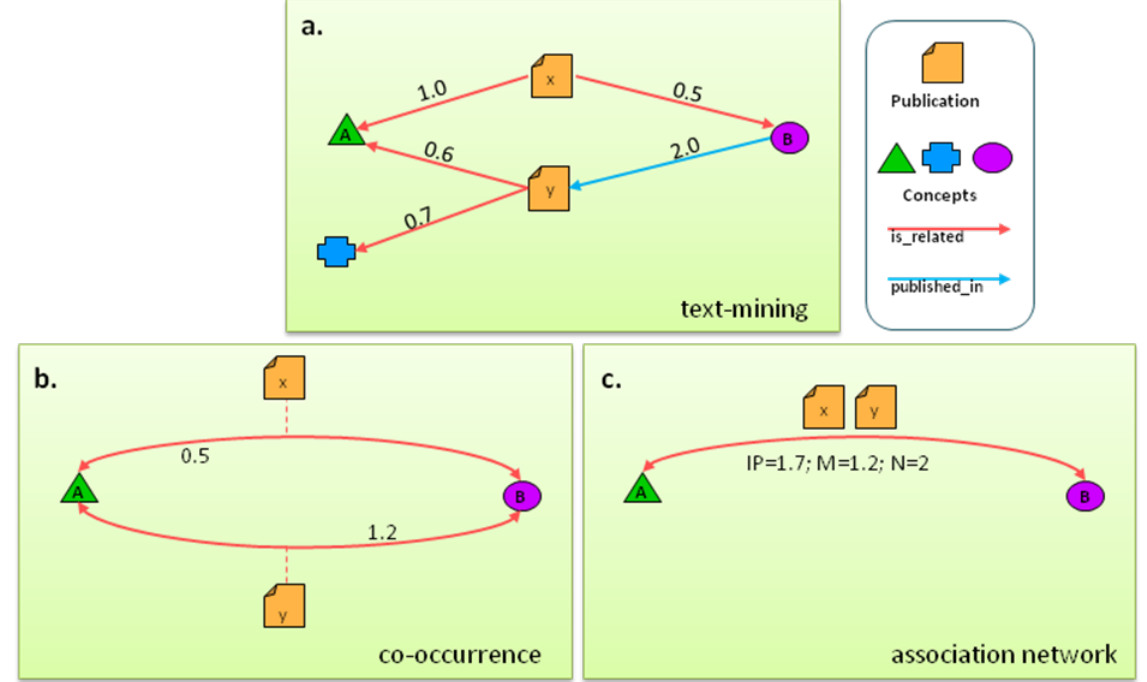
Figure 1: a) The outcome of the text mining and data integration step. The tf-idf score on a text mining based relation (red) indicates the relevance of a publication to a concept. The blue relation is imported from a manually curated database and is processed with a fixed high score.